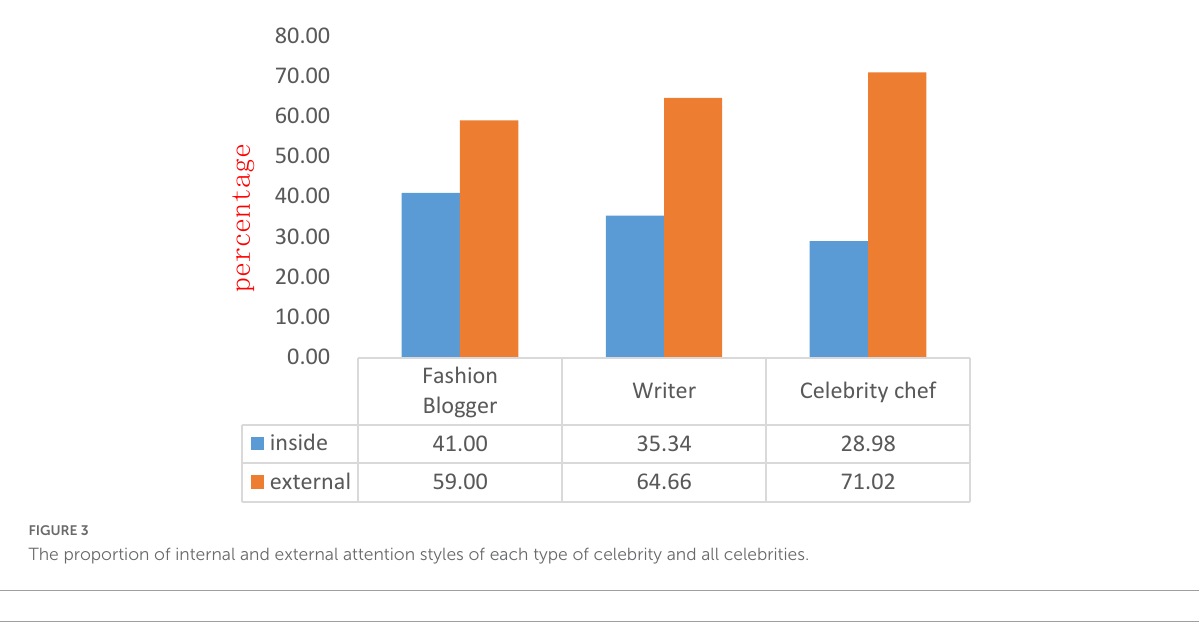
FIGURE3 The proportion of internal and external attention styles of each type of celebrity and all celebrities.